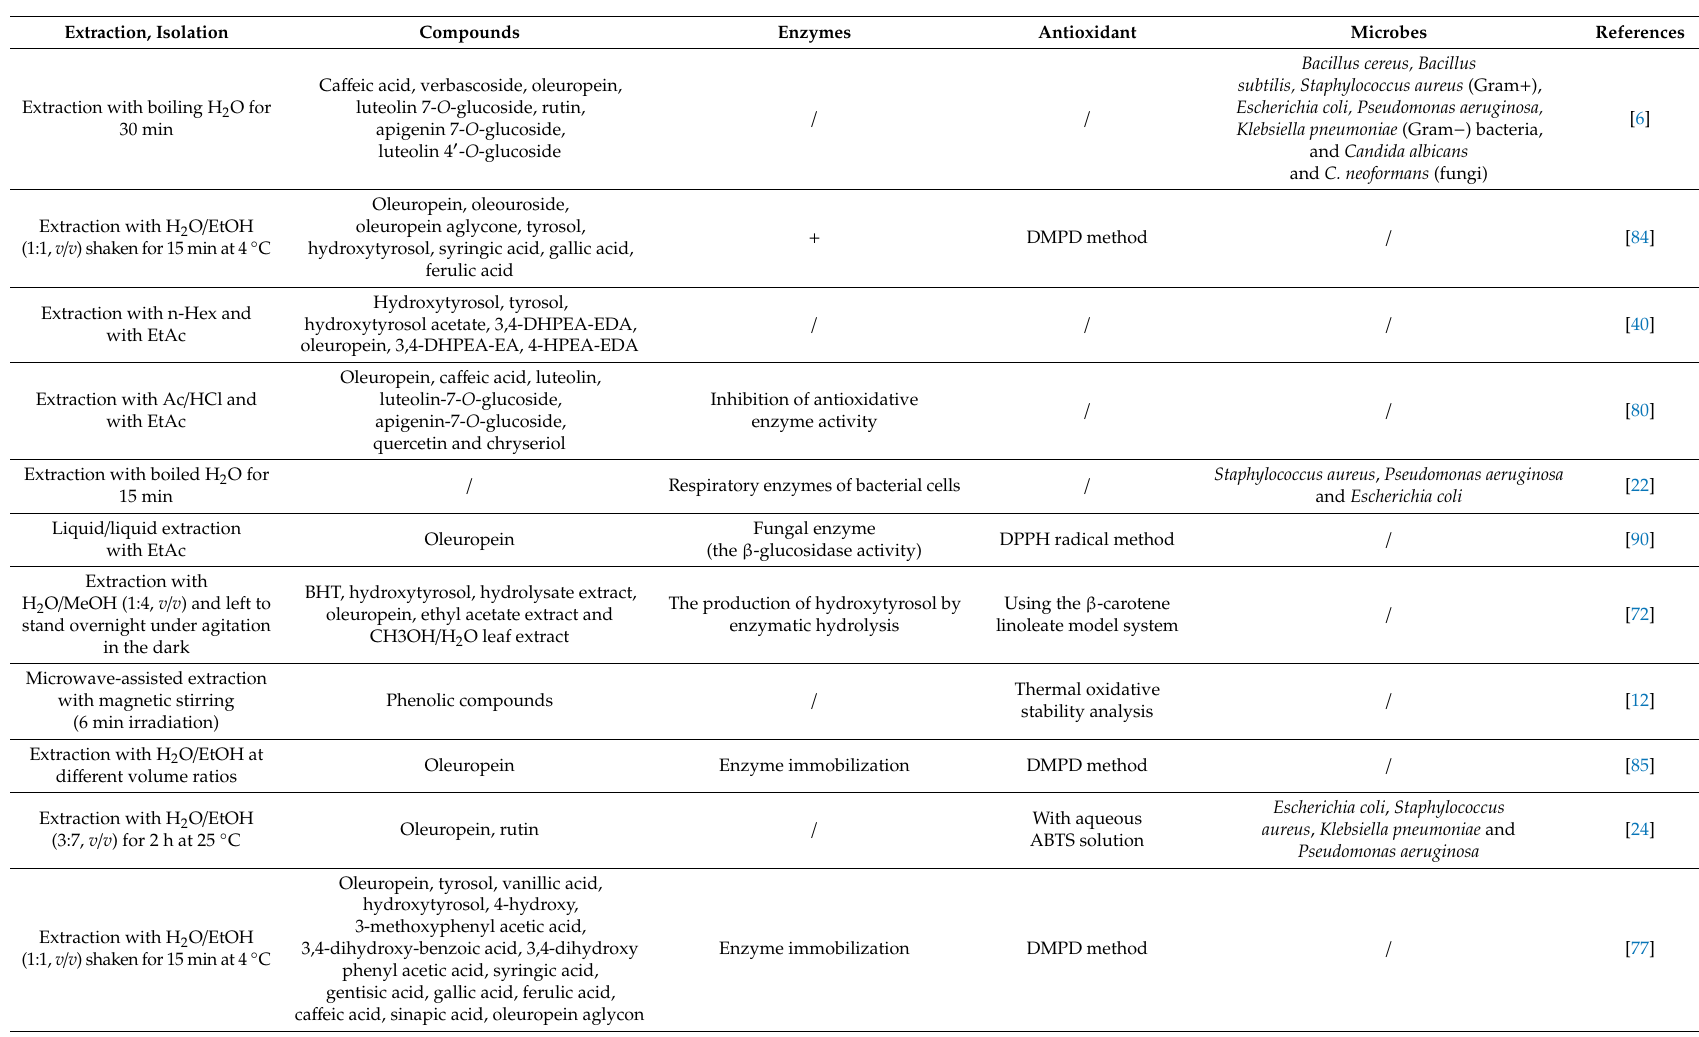
Table 1. Review of isolation methods of phenolic compounds, presence of enzymes and antioxidant and antimicrobial activity against di ff erent microbes. Extraction,